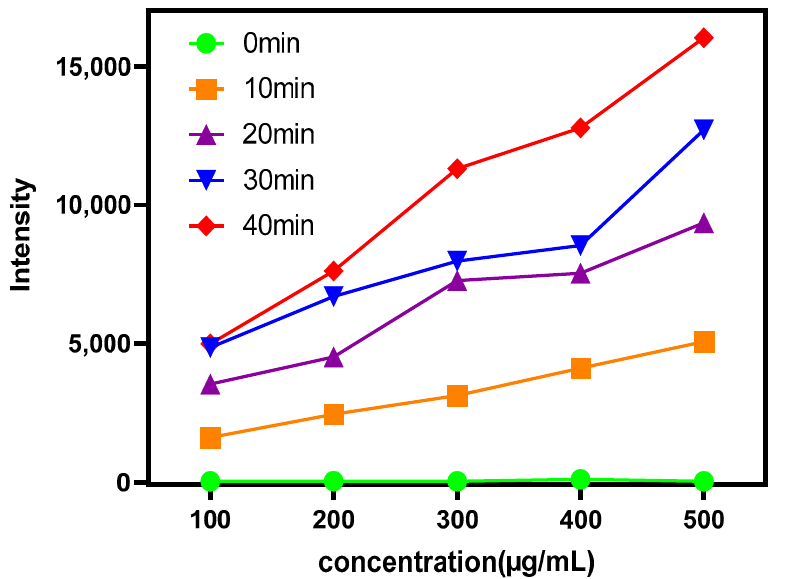
Figure 5. ROS generation by different concentrations of Au-UCNPs-DSPE-PEG2K was evaluated under near-infrared irradiation at 808 nm for different times.